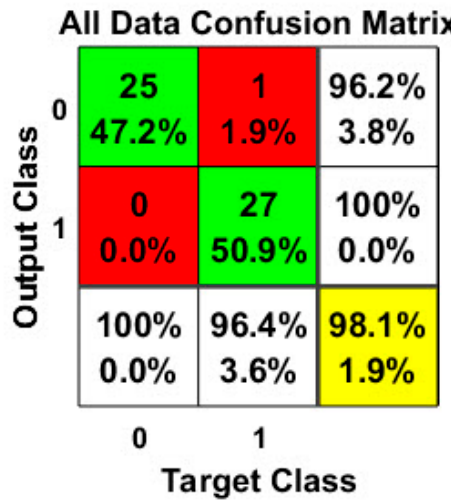
Figure 8. The results of confusion matrix for all data.